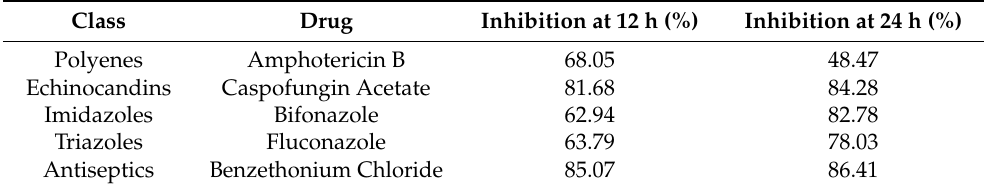
Table 1. Antifungal drugs in high-throughput